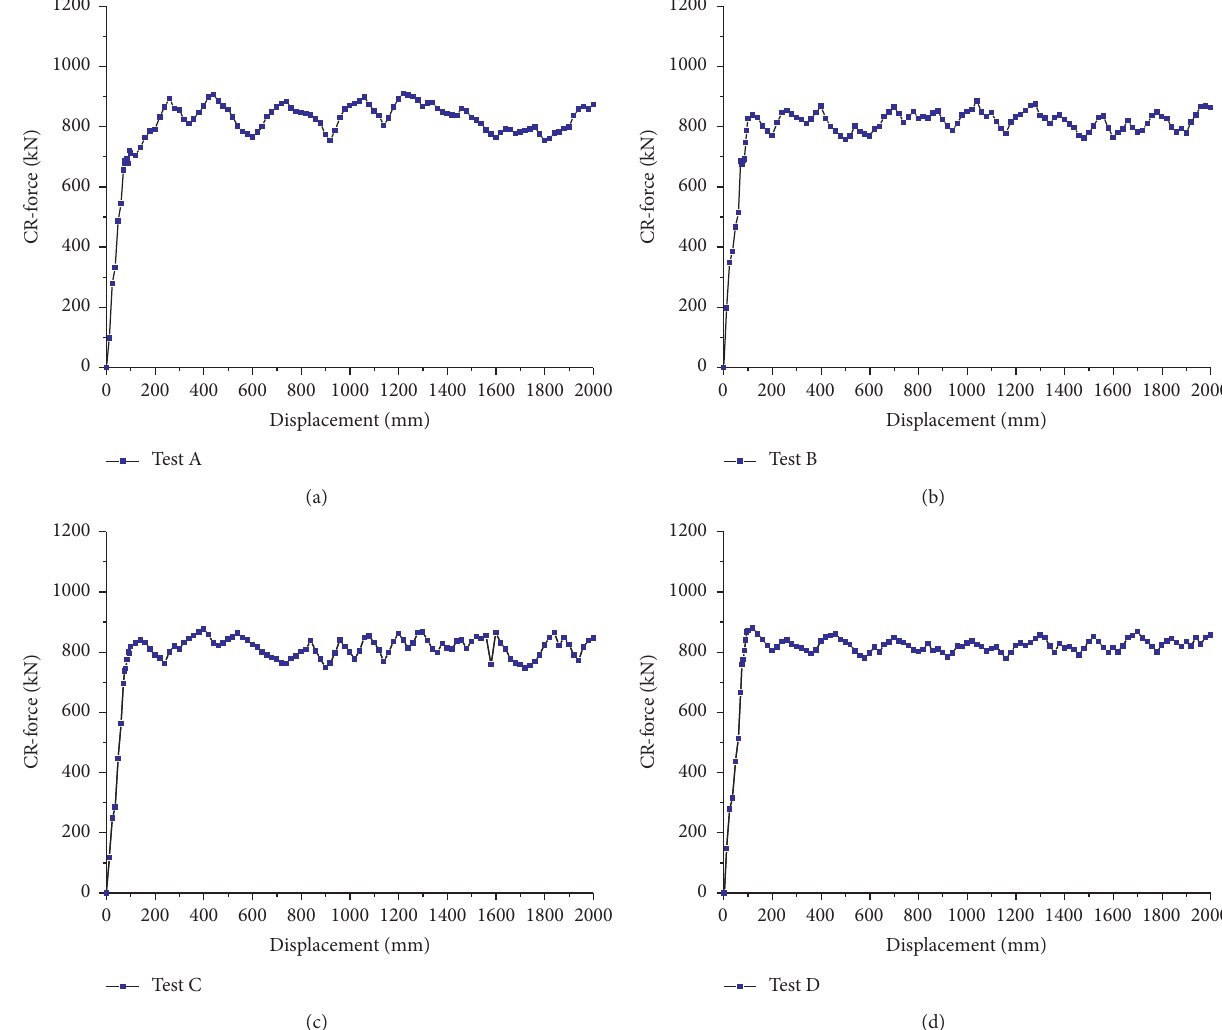
Figure 8: Constant resistance characteristic curve under different constant resistance structures.